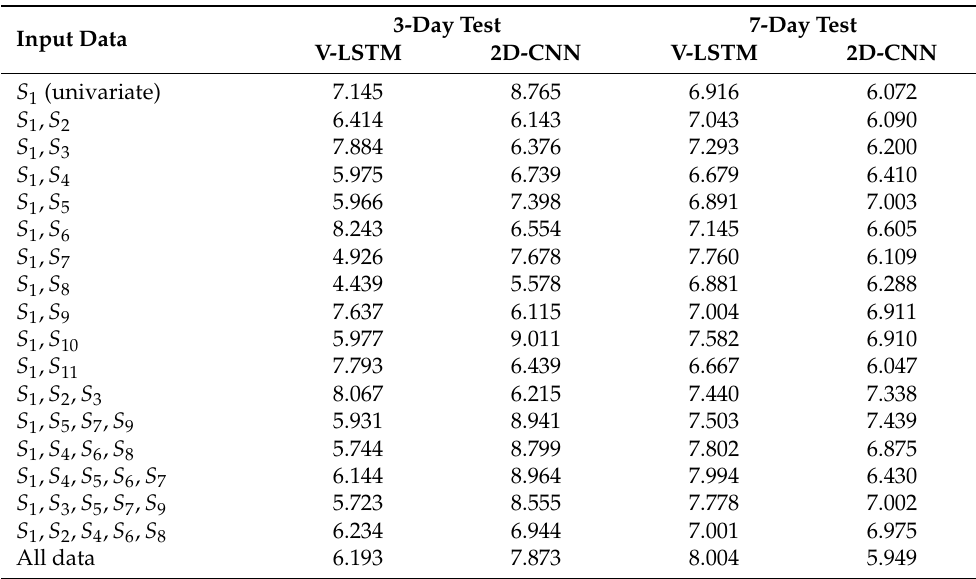
Table 2. Average RMSE for January 2018 tests, carried out by using V-LSTM and 2D-CNN models and different combinations of time series. Input Data